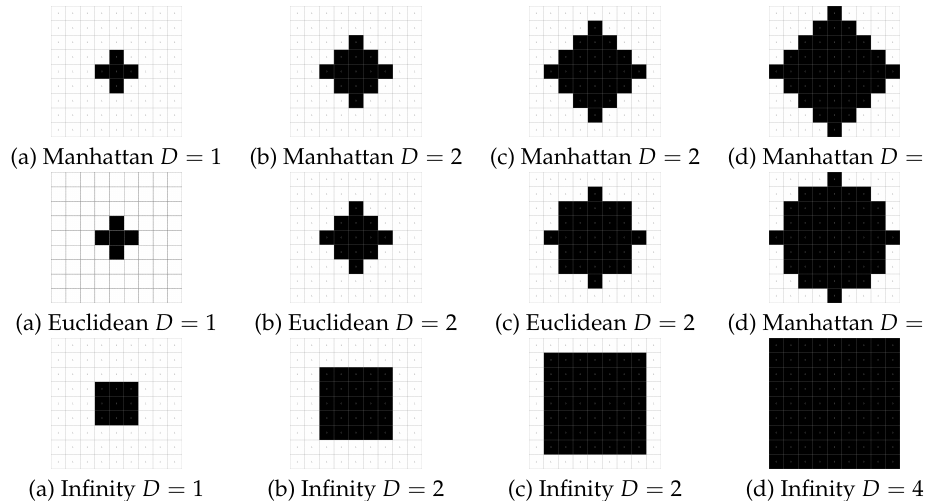
Figure 2. Evolution of the search window (in black) of noncorrupted pixels for some values of D in a 7 × 7 image and three different